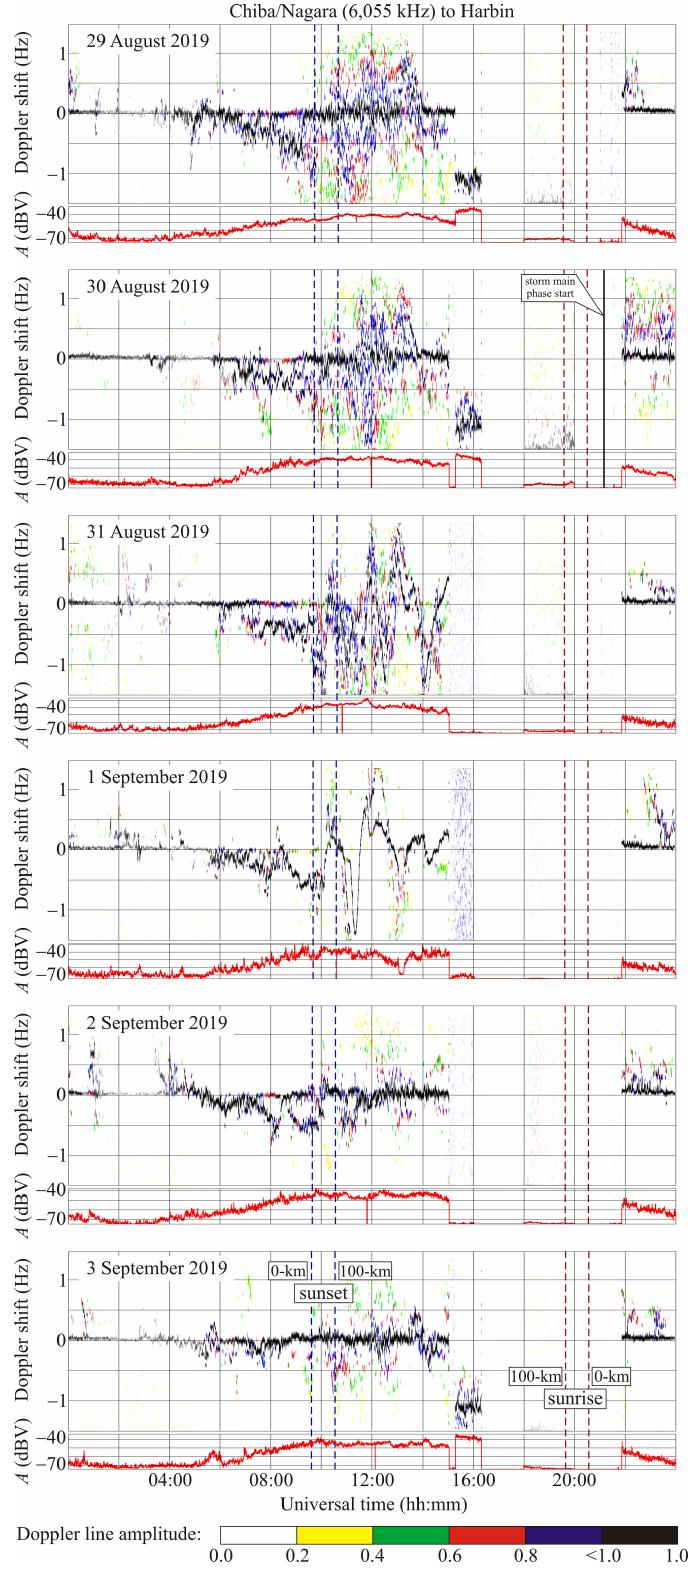
Figure 7. Same as Fig. 5 but for the Chiba/Nagara to Harbin radio wave propagation path at 6055kHz.